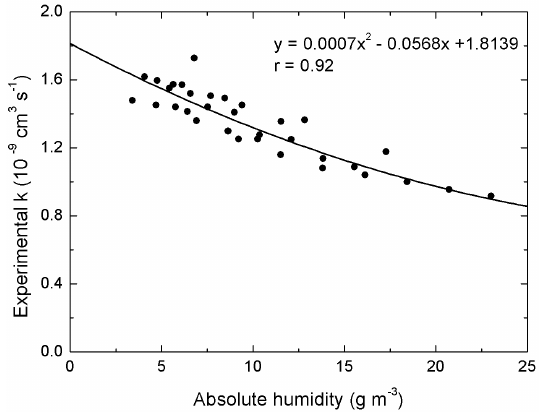
Figure 5. Experimental k value of HCHO ( m/z 31) as a function of absolute humidity in sample air.